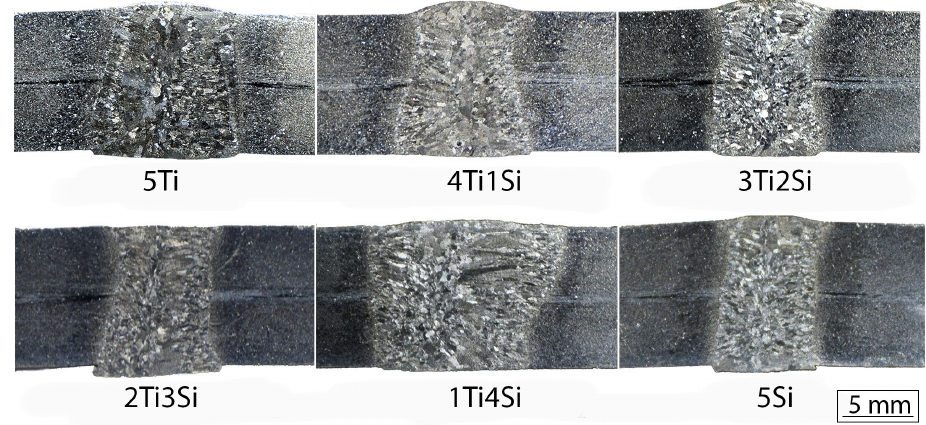
Figure 3. Macro-sections of specimens welded with various types of flux. Figure 3. Macro ‐ sections of specimens welded with various types of flux.